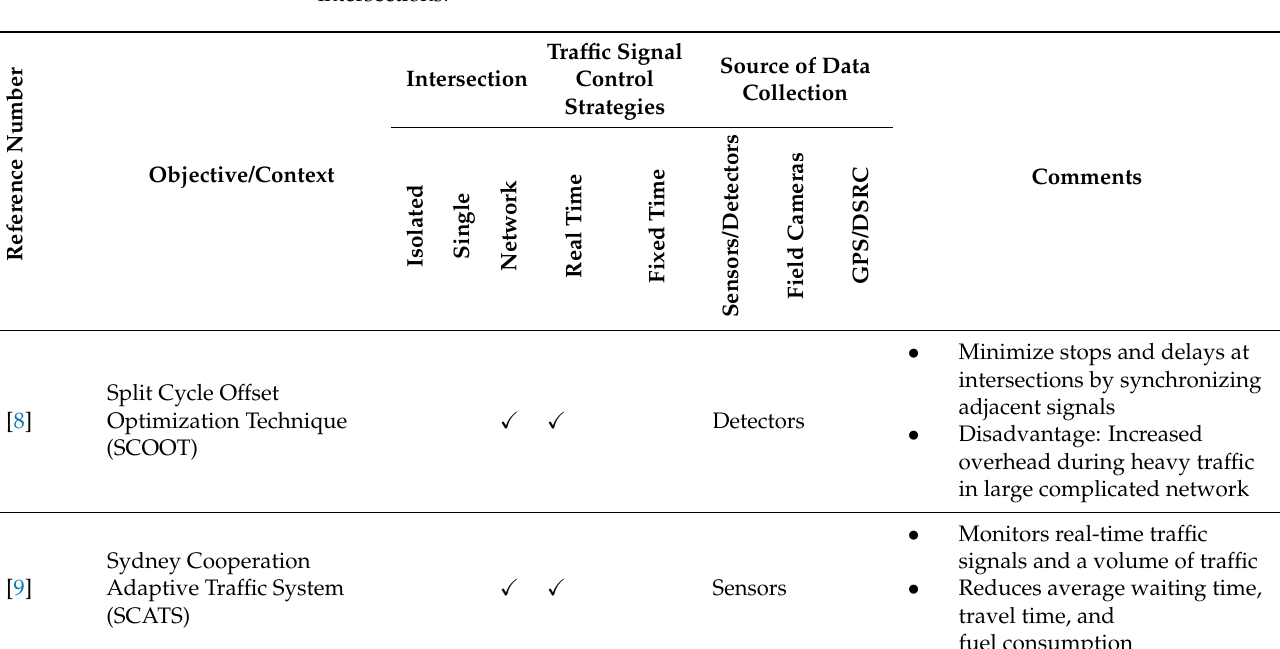
Table A2. Categorization of existing literature on techniques used for congestion control at road